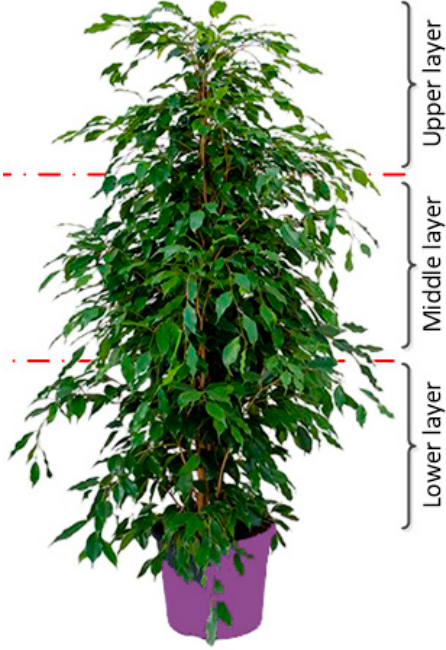
Figure 1. The demarcation of the three canopy layers.